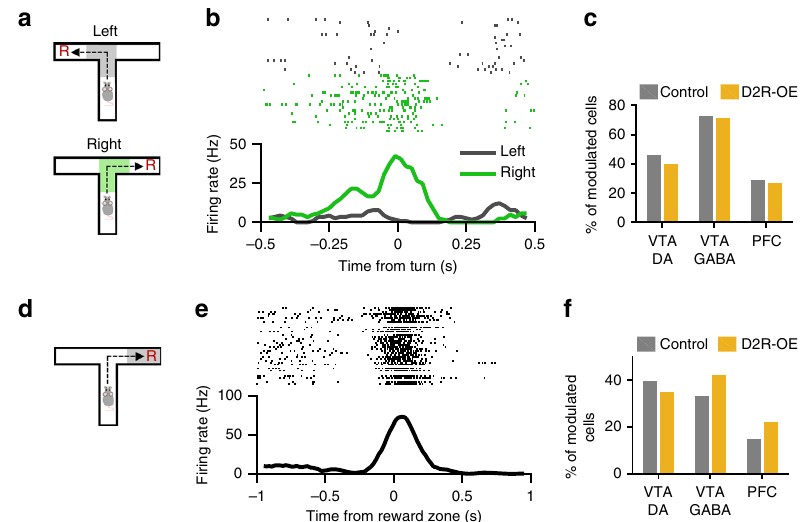
Fig. 7 Choice-related and reward-related activity of VTA and PFC neurons in D2R-OE mice. a Firing rates were compared between leftward and rightward turns during the WM task. b Example of a VTA neuron that was more active when the mouse made a rightward turn. c The proportion of VTA DA (Control: n = 113; D2R-OE: n = 102), VTA GABA (Control: 124; D2R-OE: n = 104) and PFC (Control: n = 187; D2R-OE: n = 185) neurons whose fi ring rate differed signi fi cantly between left and right turns ( − 500 to + 500 ms around turn onset; see Methods) did not differ between the two genotypes (VTA DA: p = 0.41, VTA GABA: p = 0.88, PFC: p = 0.73, Fisher ’ s exact test). d Firing rates were examined around the time when animals reached the reward zone (R) in the T-maze. e Example of a VTA neuron responding to reward at the end of the goal arm. f Proportion of reward-responsive neurons ( n values as in c ; see Methods) in VTA and PFC did not differ between the two genotypes (VTA DA: p = 0.48, VTA GABA: p = 0.17, PFC: p = 0.08, Fisher ’ s exact